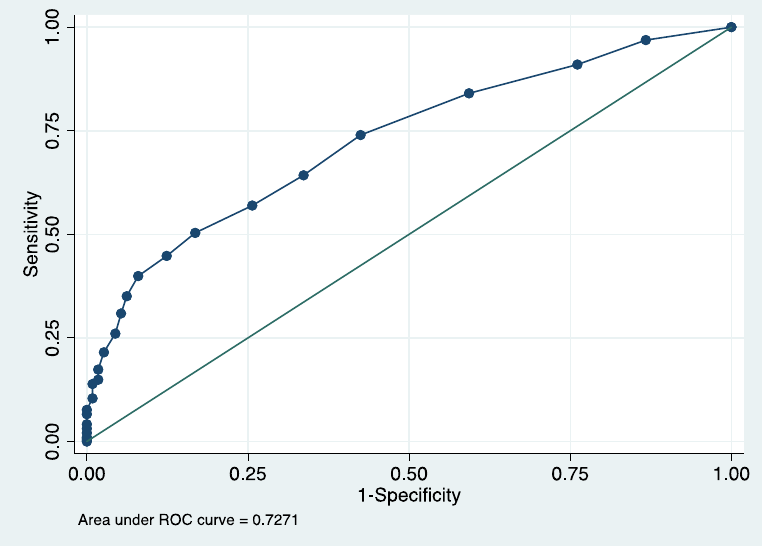
Figure 3. The receiver operator characteristic curve by heat stress and endemic region for agricultural workers.